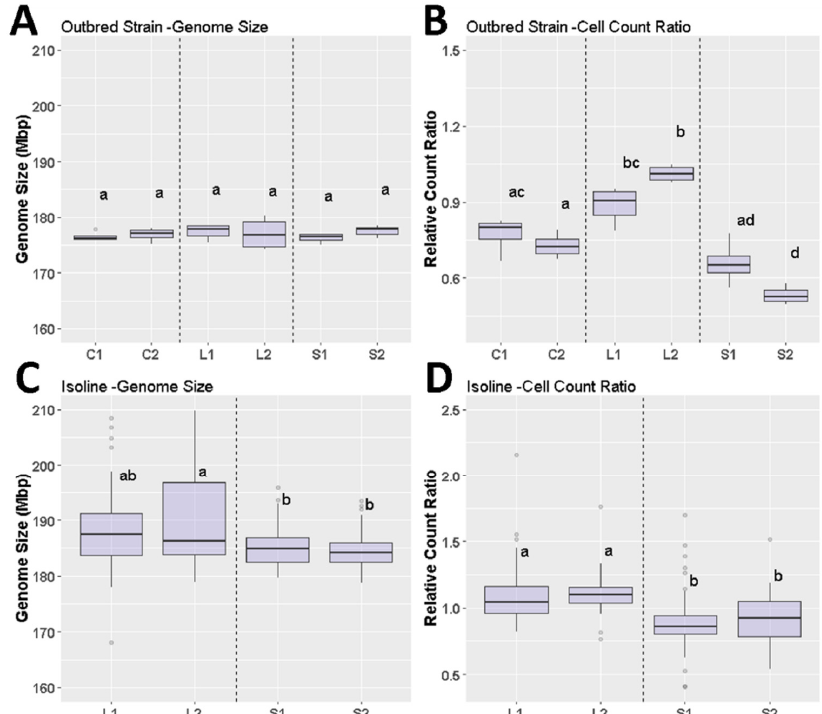
Figure 3. Boxplot comparisons of genome size and cell-counts between D. melanogaster di ff erentially selected for body size. Genome size and cell-counts plotted by strain for outbred strains and isolines. Di ff erent letters above each box represent values significantly di ff erent according to Tukey HSD at the p < 0.05 level. ( A ) Genome size variation for outbred populations in control lines (C1, C2), large selected lines (L1, L2), and small selected lines (S1, S2). ( B ) Variation in cell-count ratio for outbred populations in control lines (C1, C2), large selected lines (L1, L2), and small selected lines (S1, S2). ( C ) Genome size variation for isolines developed from outbred populations for large-body size selected lines (L1, L2) and small-body size selected lines (S1, S2). ( D ) Variation in cell-count ratio for isolines developed from outbred populations for large-body size selected lines (L1, L2) and small-body size selected lines (S1,